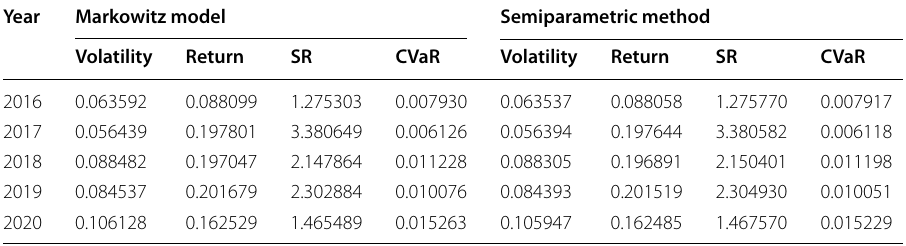
Table 7 The summary of out‑of‑sample results for Markowitz model and semiparametric method 0.05 with CVaR ( α =